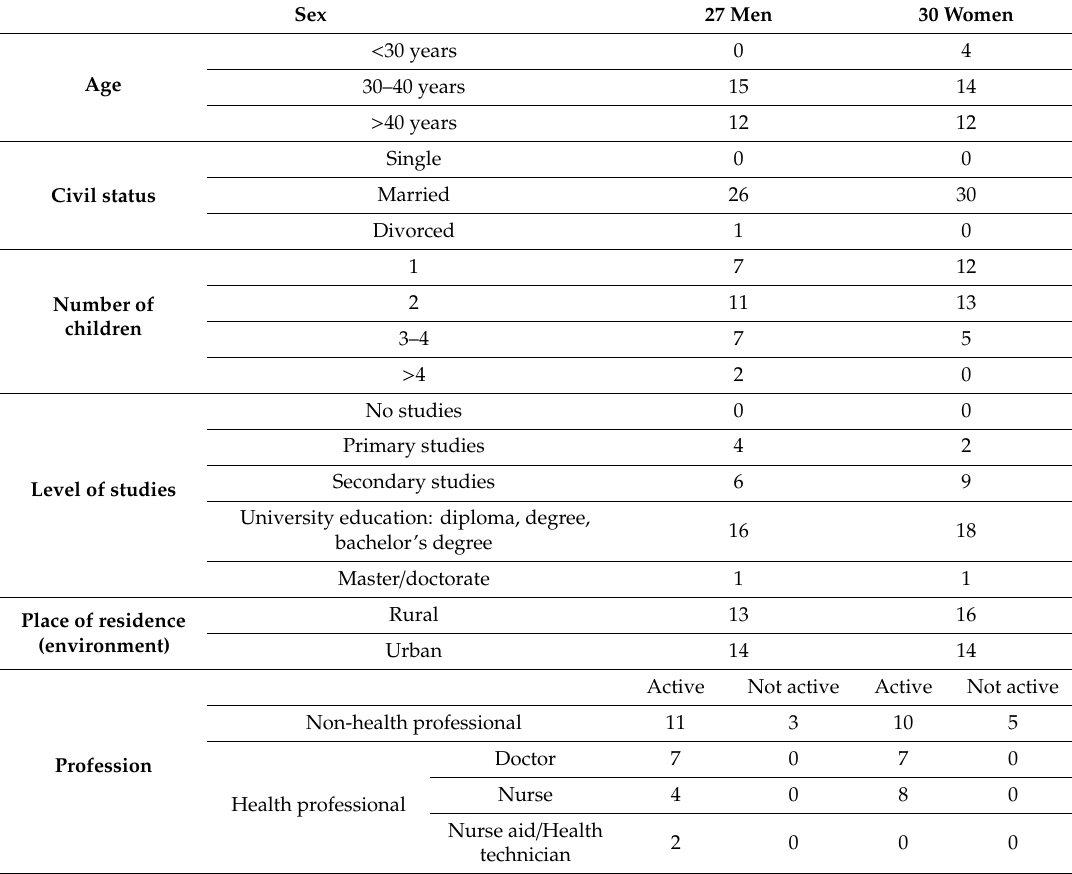
Table 1. Principal characteristics of parents participating in the focus